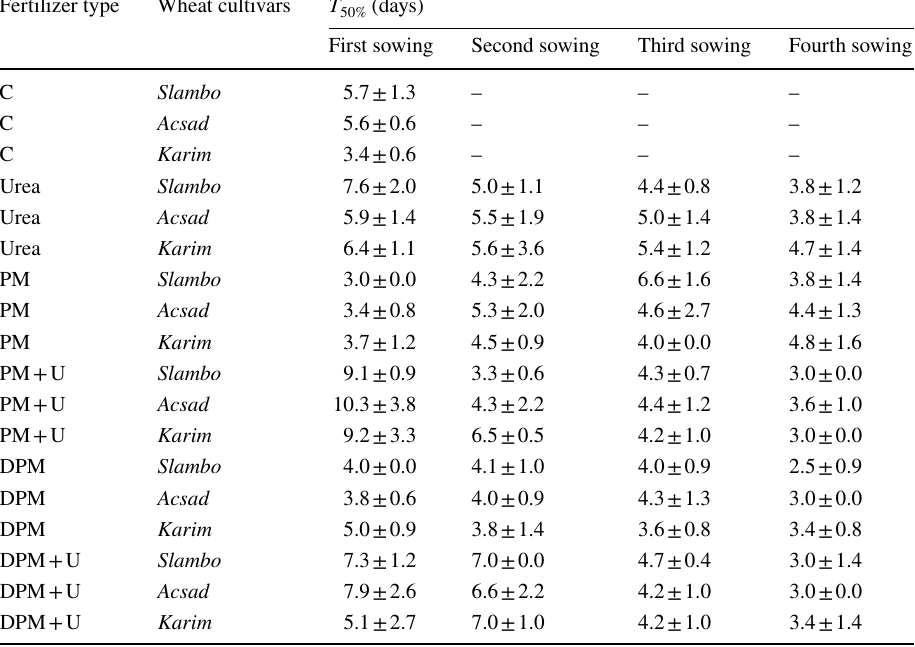
Table 4 The time to reach 50% germination ( T 50% ) of three wheat cultivars ( Slambo , Acsad and Karim ) after 14 days growing period sown in desert soil on four sowing dates after amendment with non-digested and anaerobically digested poultry manure with and without combination with urea